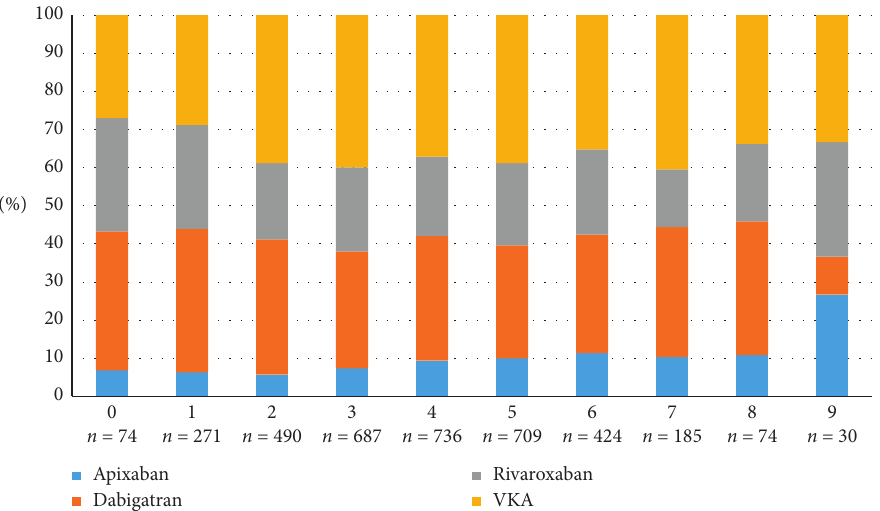
Figure 3: Prescription pattern of oral anticoagulants based on CHA2DS2-VASc